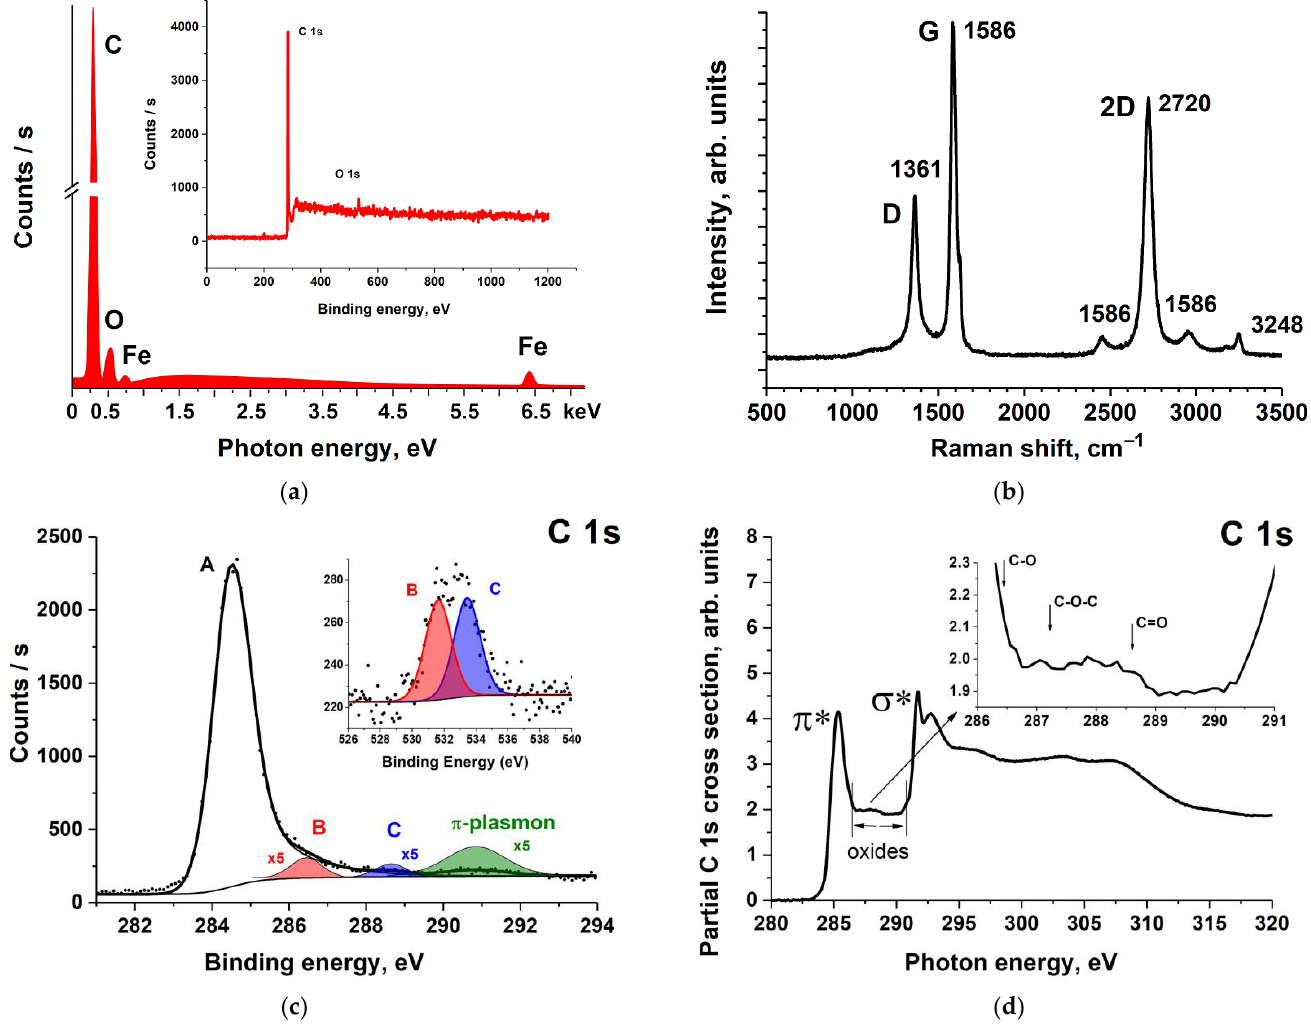
Figure 2. Characterization of the initial MWCNTs: ( a ) EDS (bottom) and XPS (top) survey spectra, ( b ) Raman spectra, ( c ) C 1s and O 1s XPS spectra, and ( d ) C 1s NEXAFS spectrum.